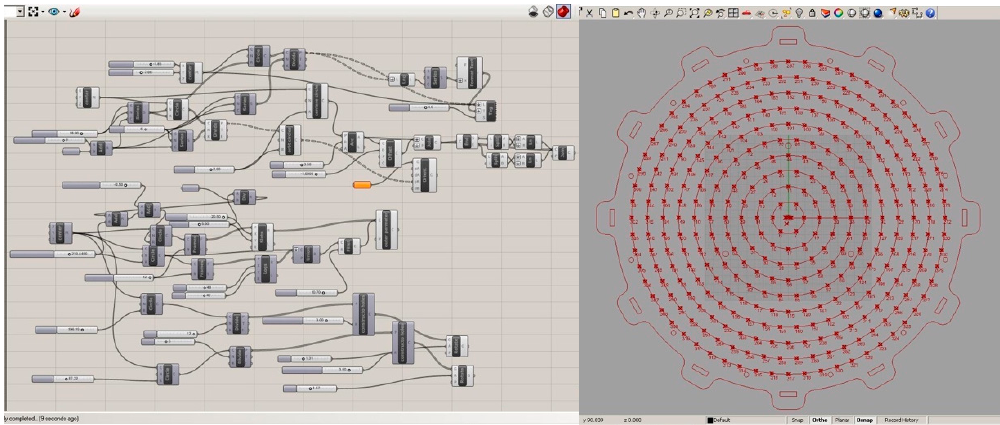
Figure 2. The Grasshopper definition created to aid the development of the files for the matrix plates for the round glass RPT systems. The matrix plate design, illustrated in the image to the right, is defined by the Grasshopper script on the left, (images by Jorgensen, T. 2011)